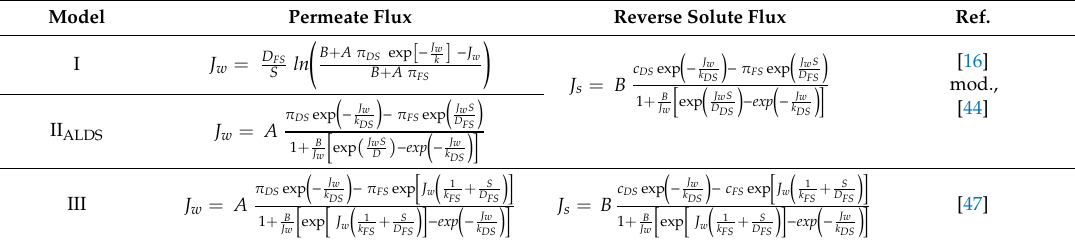
Table 3. Model equations for permeate and reverse solute flux using an ALDS membrane orientation. Model